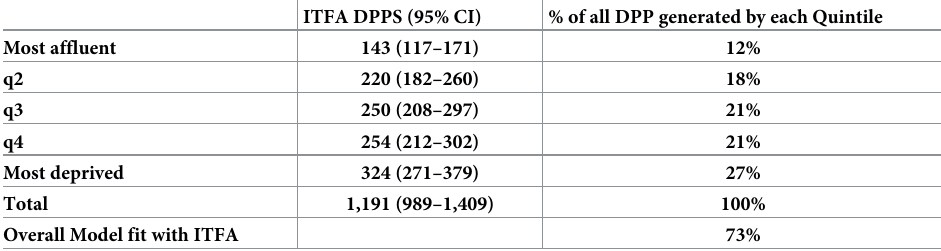
Table 2. Deaths prevented or postponed in Danish men and women in 2007 attributable to the decrease in ITFA, by socio-economic quintiles. ITFA DPPS (95% CI) % of all DPP generated by each Quintile Most affluent 143